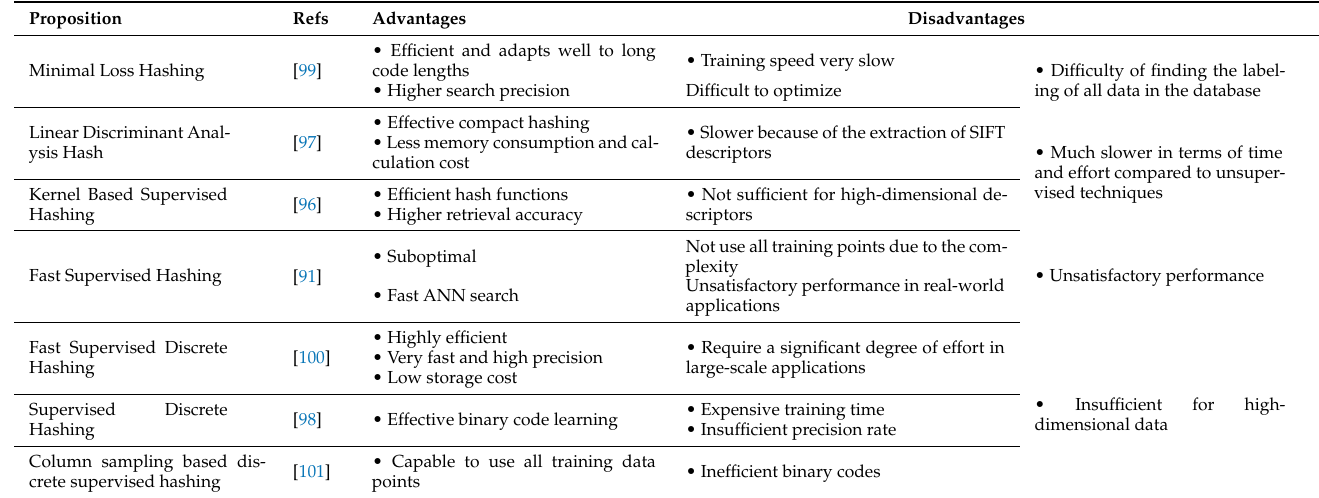
Table 4. Summary of advantage and disadvantage of supervised hashing